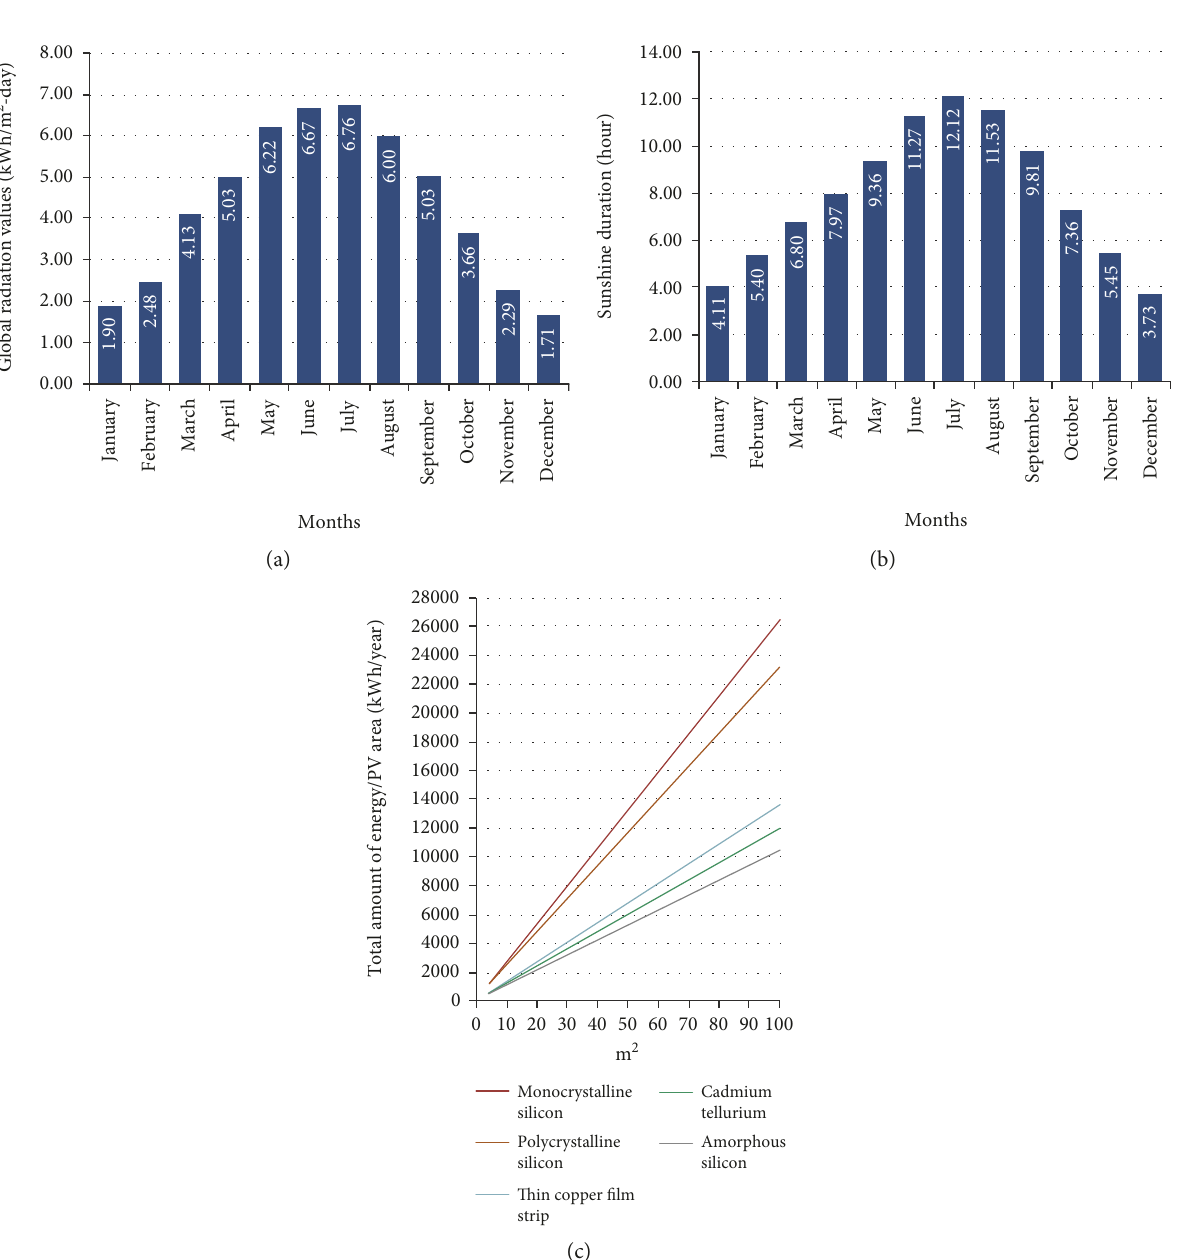
Figure 5: Aksaray province (a) global radiation values, (b) sunshine duration, and (c) total amount of energy/PV